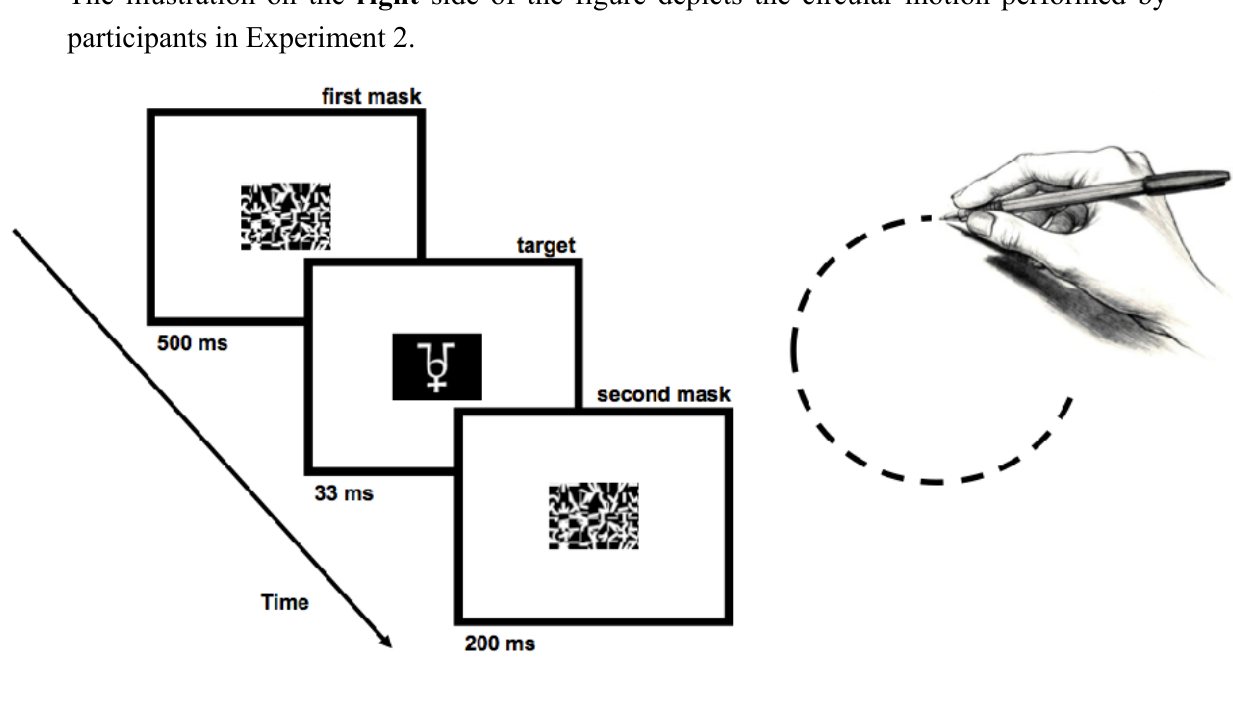
Figure 1. Schematic illustration of the time course of trial events in Experiment 1 ( left